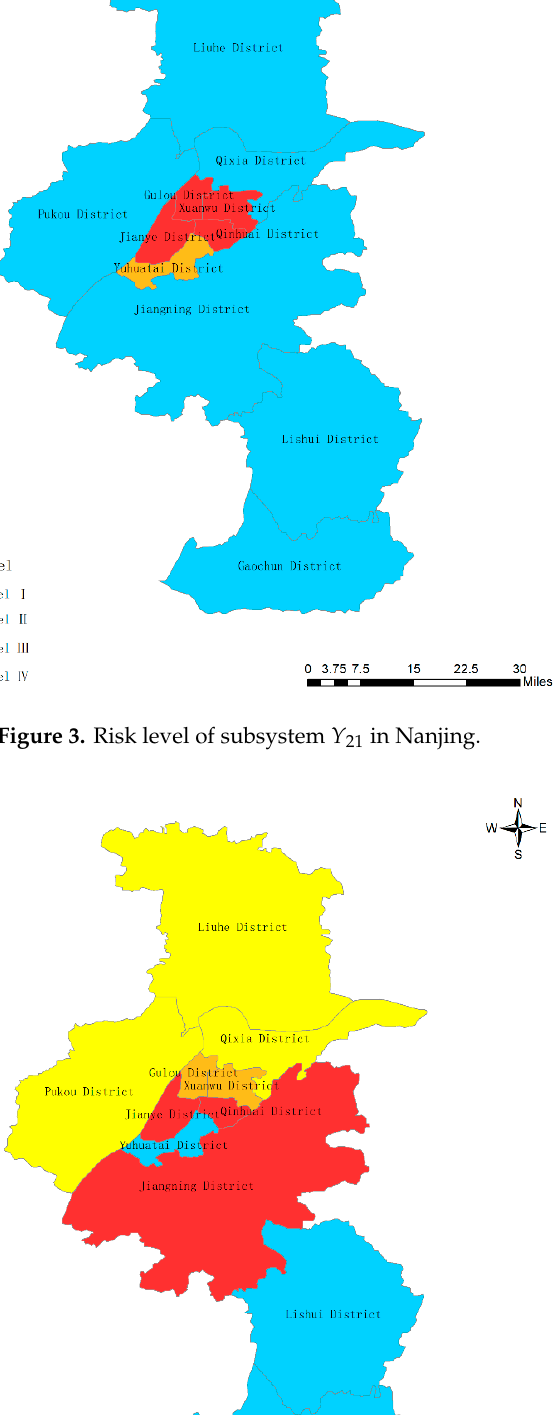
Figure 5. Risk level of subsystem 𝑌 (cid:2870)(cid:2871) in Nanjing.